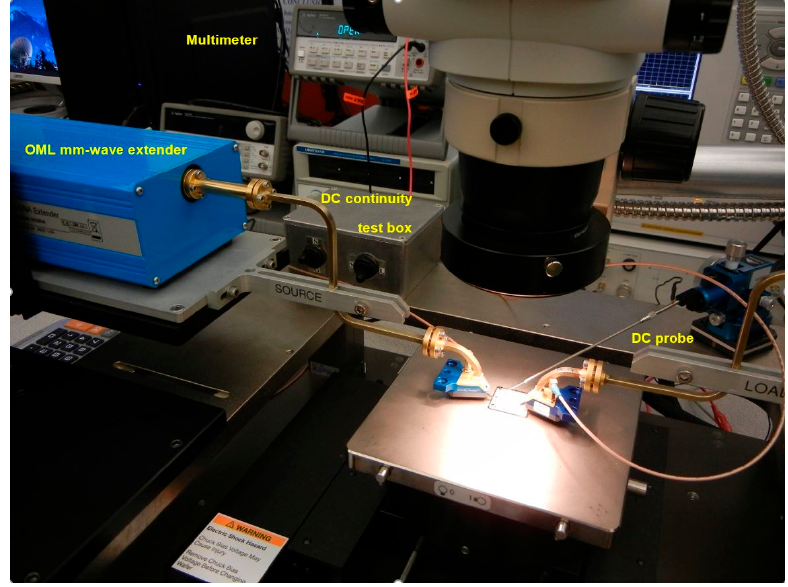
Figure 23. Measurement set-up: millimeter wave probe station and vector network analyzer (VNA). Details of the S-parameter measurements set-up, including a MHMIC die under test, are presented in Figures 24 and 25.